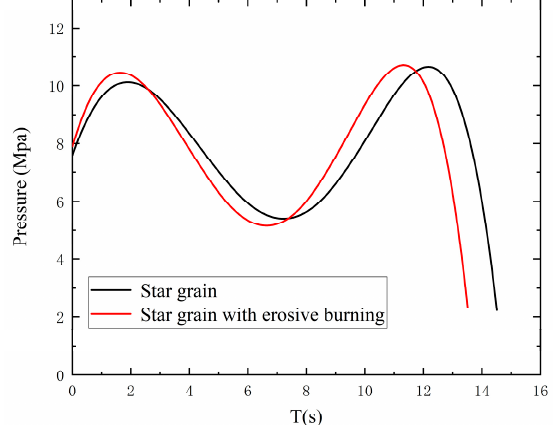
Figure 17. 0-D internal ballistic P-T diagram of Star grain under synthesis algorithm.